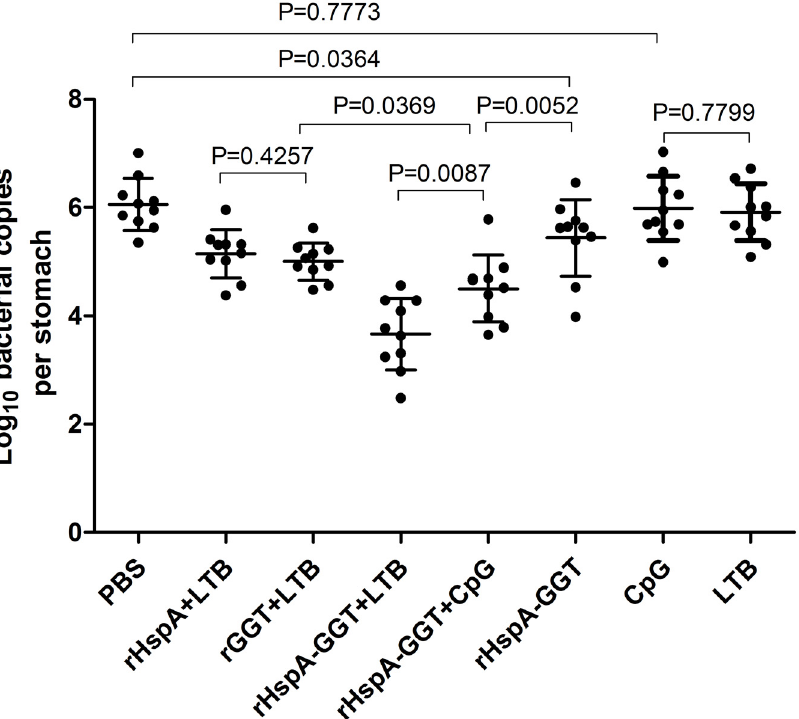
Fig 2. H . pylori colonization in mouse stomachs after immunization. BALB/c mice (n = 10) were immunized intranasally on days 0, 14 and 21 with 30 μ g antigen, with or without 10 μ g adjuvant, as indicated in Table 1. The same volume of PBS was used as a negative control. Three weeks after the final vaccination boost, mice were orally challenged four times with H . pylori B6. The level of gastric H . pylori colonization was determined by real-time quantitative PCR four weeks post challenge for each mouse. Data are expressed as mean ± S.D. Significant differences between indicated groups are presented as P